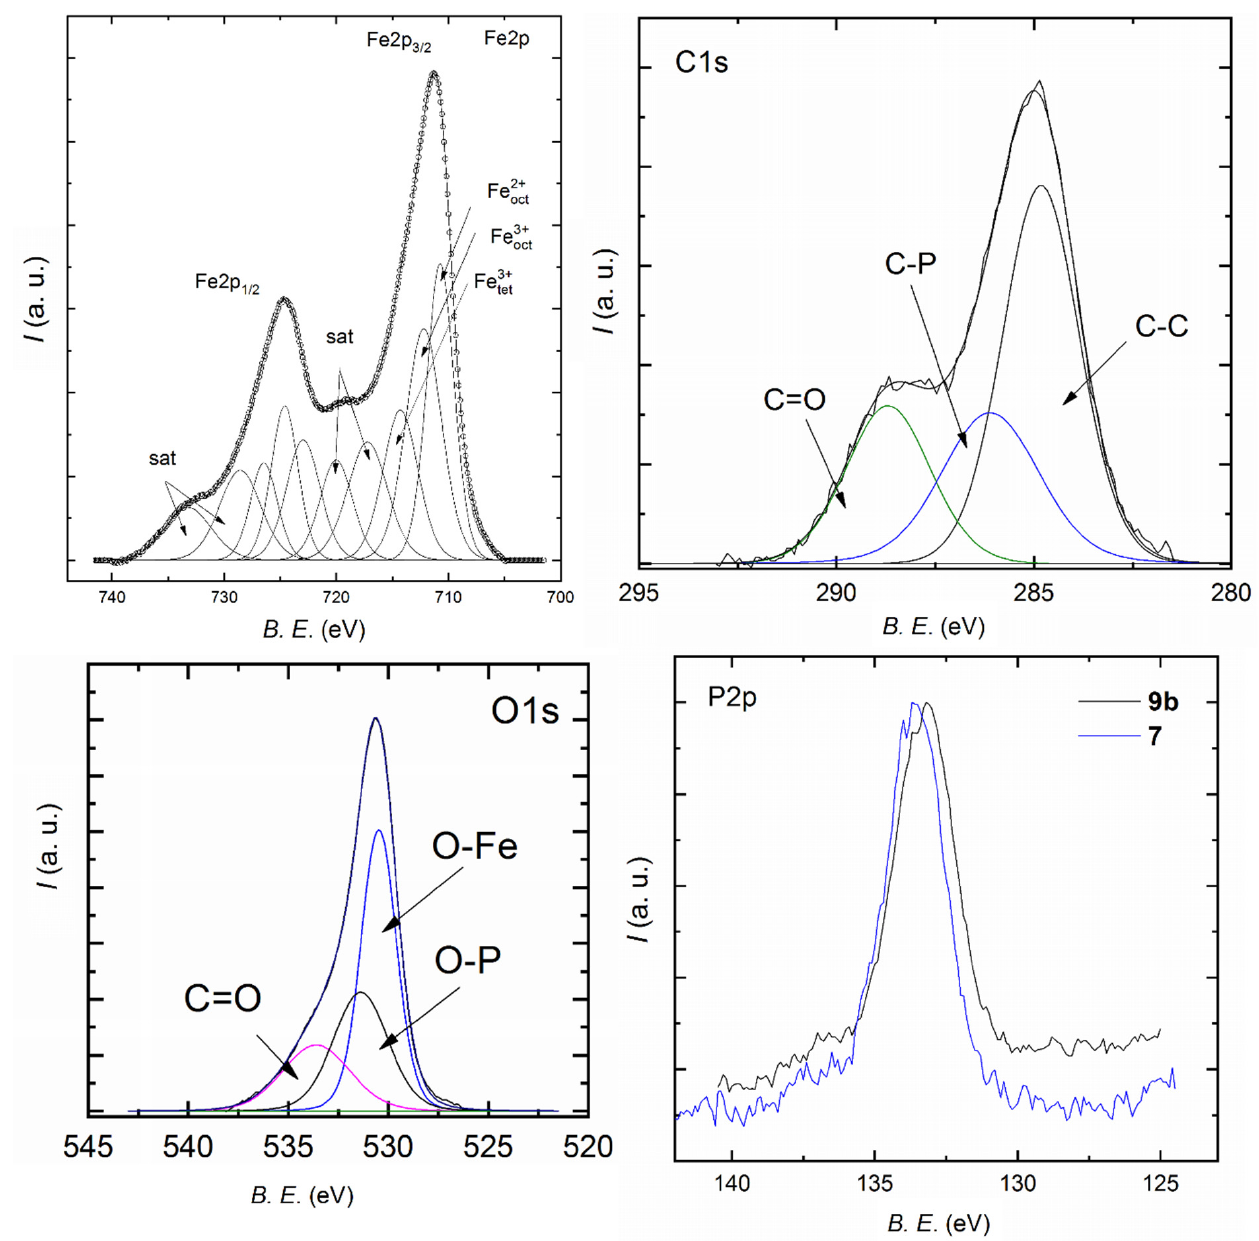
Figure 2. XPS core level spectra (Fe2p, C1s, O1s) of 7 and P2p of 7 and 9b .